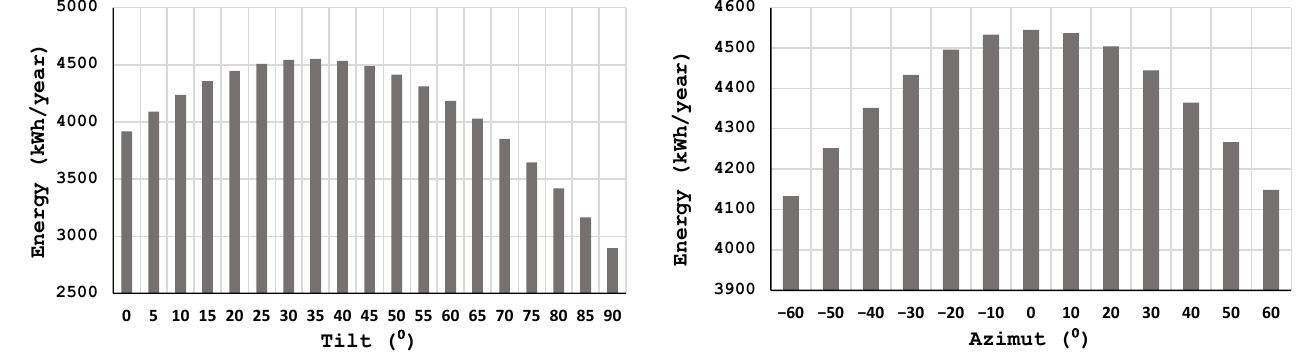
Figure 1. An energy simulation study. Left: Tilt. Right: Orientation.